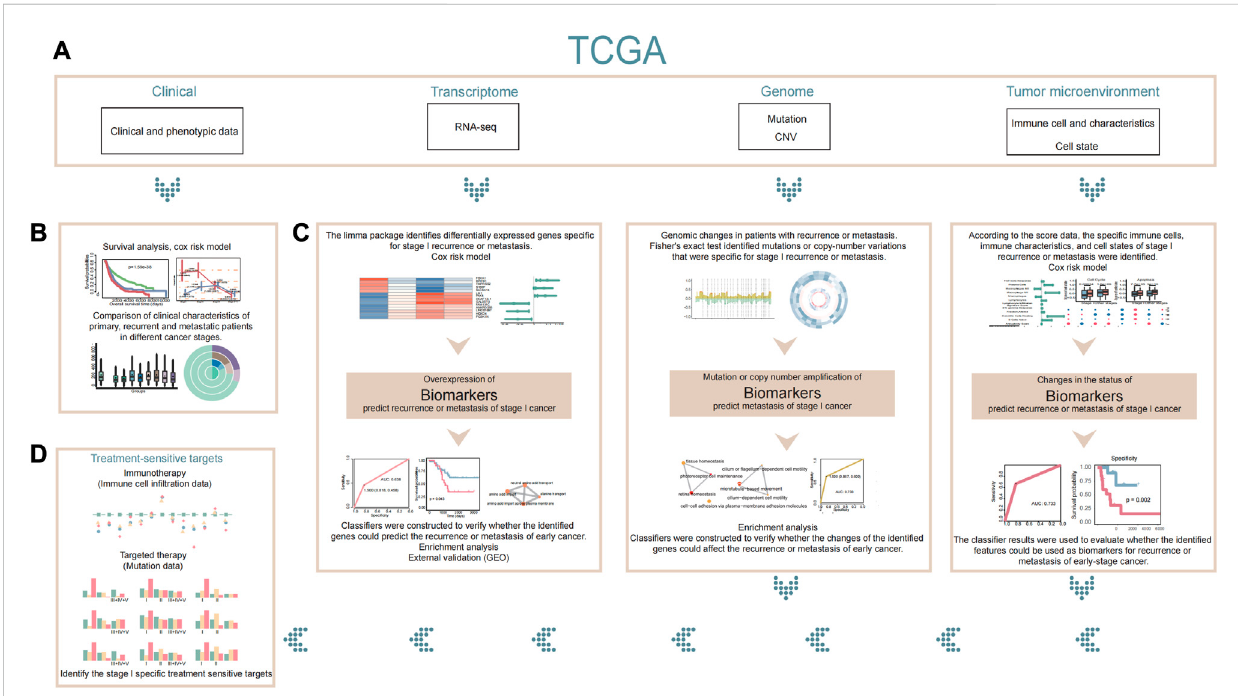
Flowchart. (A) Our study is based on clinical phenotypic data, transcriptome data, genomic data, and tumor microenvironment data in TCGA. (B) First, we compared the differences in clinical characteristics between patients with stage I recurrence or metastasis and patients with other stages based on clinical data. (C) Next, we used transcriptome, genomic, and tumor microenvironment data to explain and analyze the differences in patients with stageIrecurrenceormetastasisandtoidentifystageI-speci fi cbiomarkersthatmightpredictrecurrenceormetastasisofearlycancer. (D)